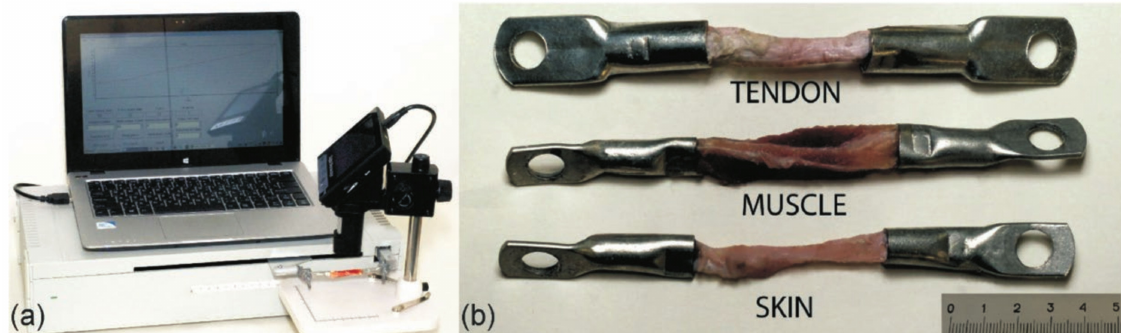
Figure 2. ( a ) Universal tensile testing machine and ( b ) soft biological tissues